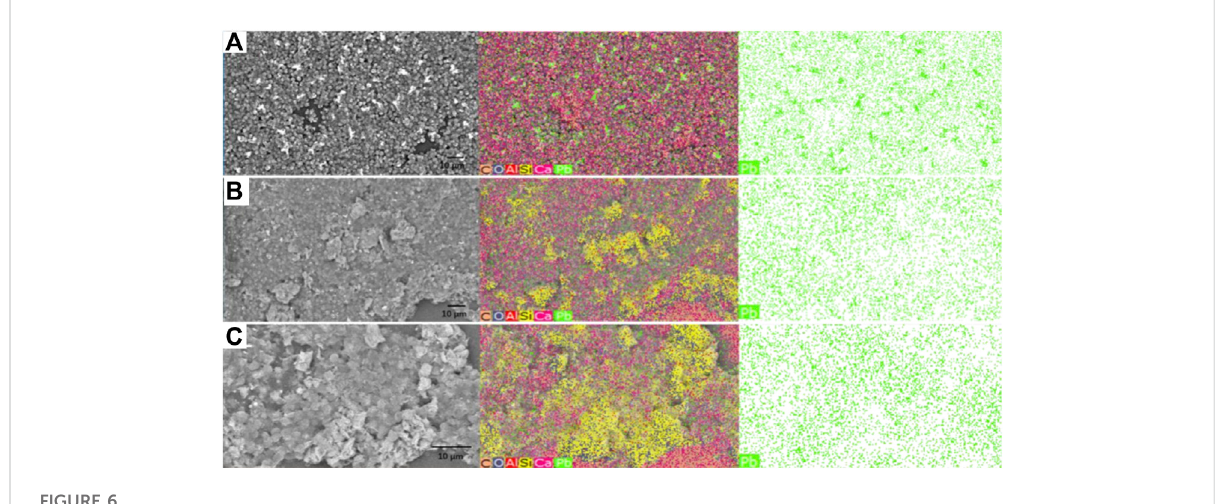
FIGURE 6 SEM-EDS image of (A) Chlorella , (B) Chlorella – MMT (1:1), and (C) Chlorella – MMT